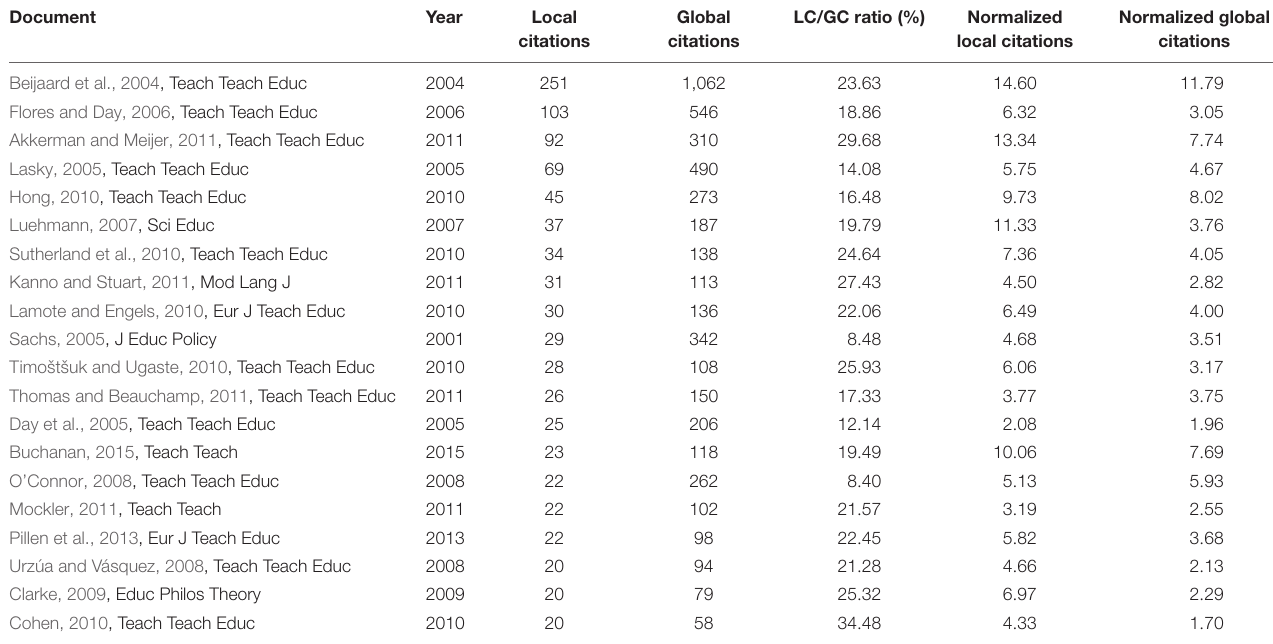
Figure 3 sheds light on the connection network of